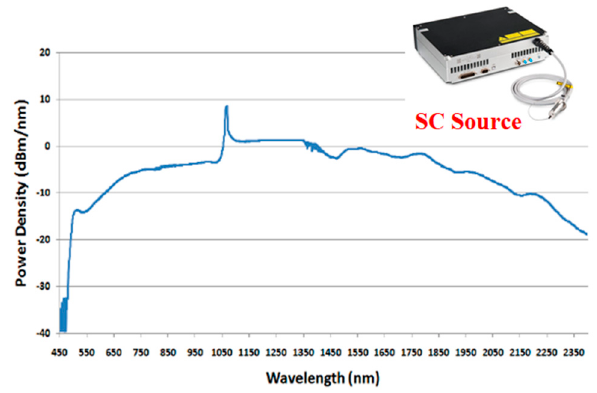
Figure 2. The supercontinuum laser source and the power density against the wavelength.